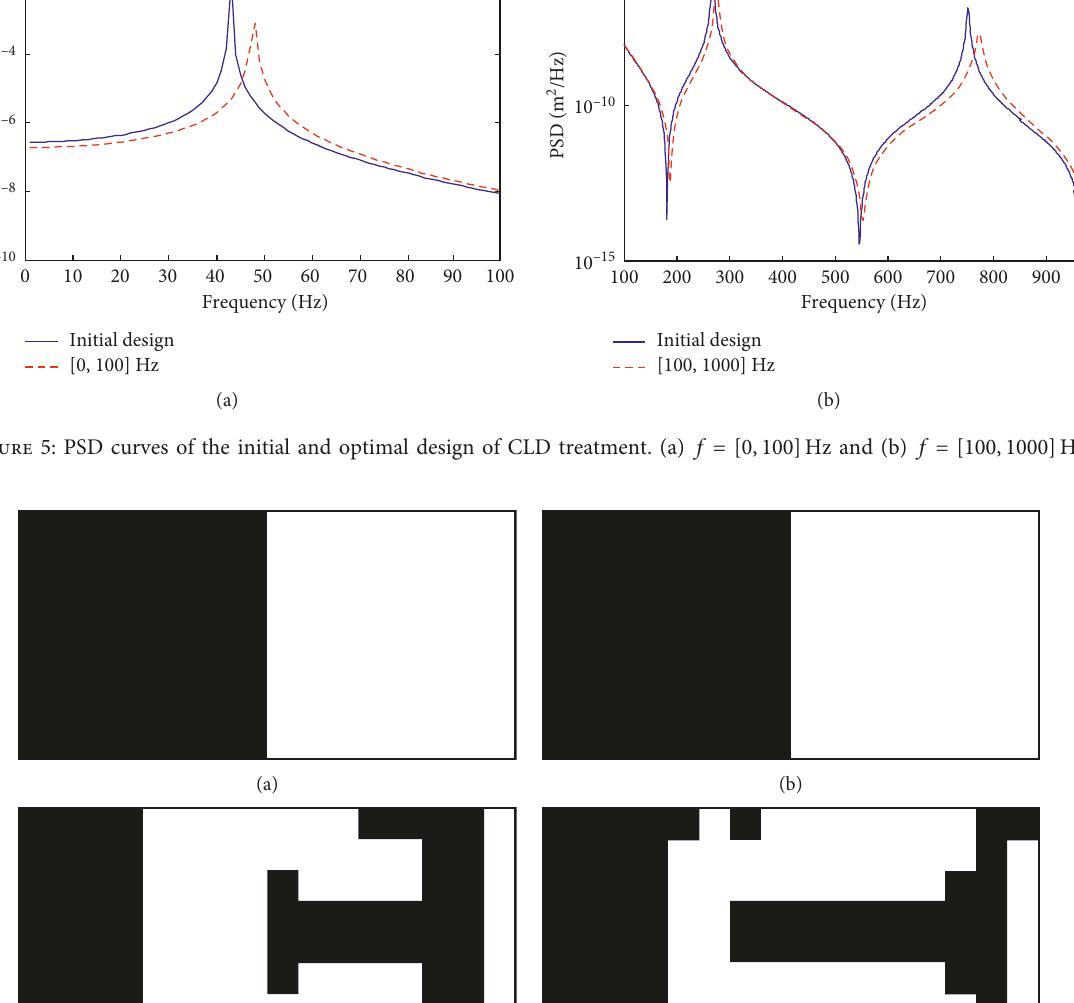
0 , 100 Hz and (cid:31) [ ] 100 , 1000 Hz (cid:31) [ ]